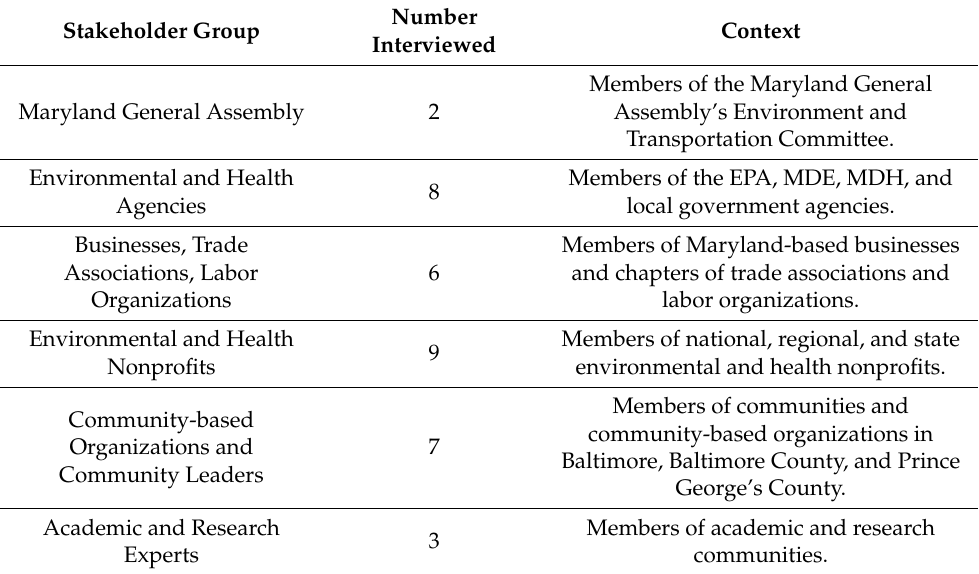
Table 2. Interviewed participant